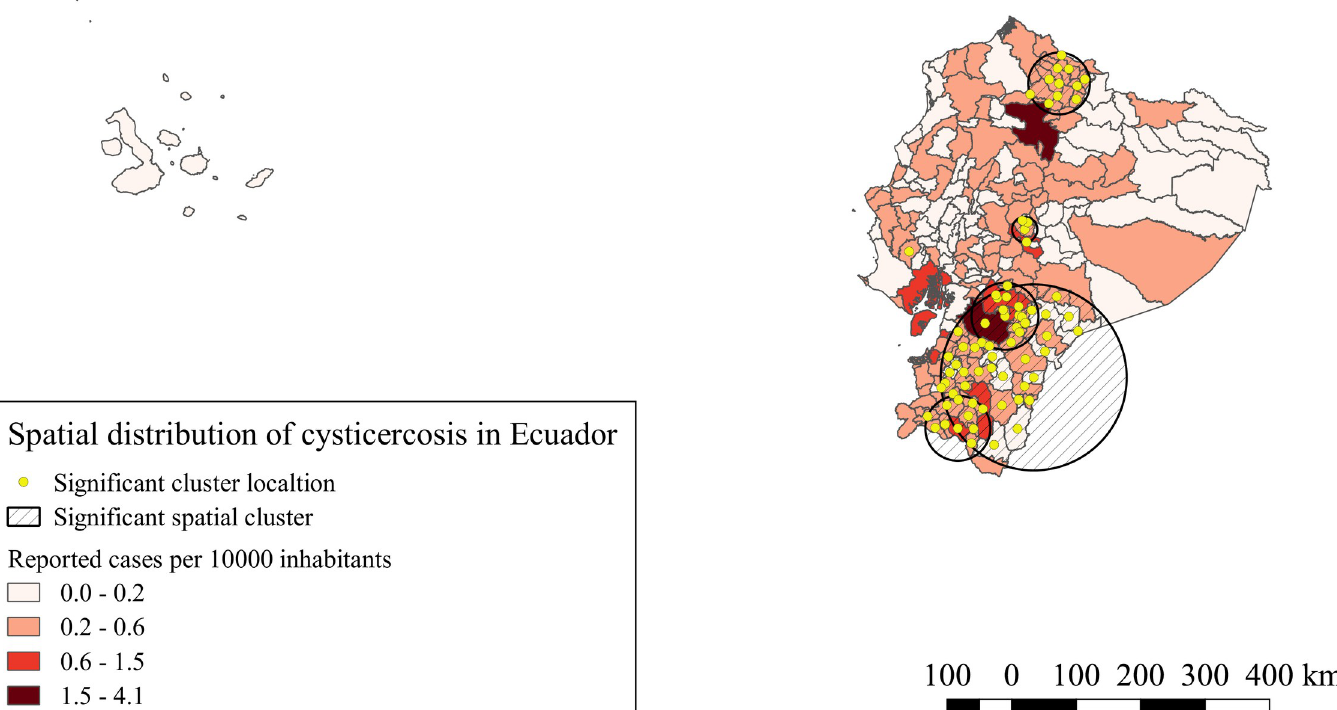
Fig 1. Spatial distribution and significant space clusters of NCC hospitalized cases in Ecuador. Shape files for this map were obtained from INEC portal